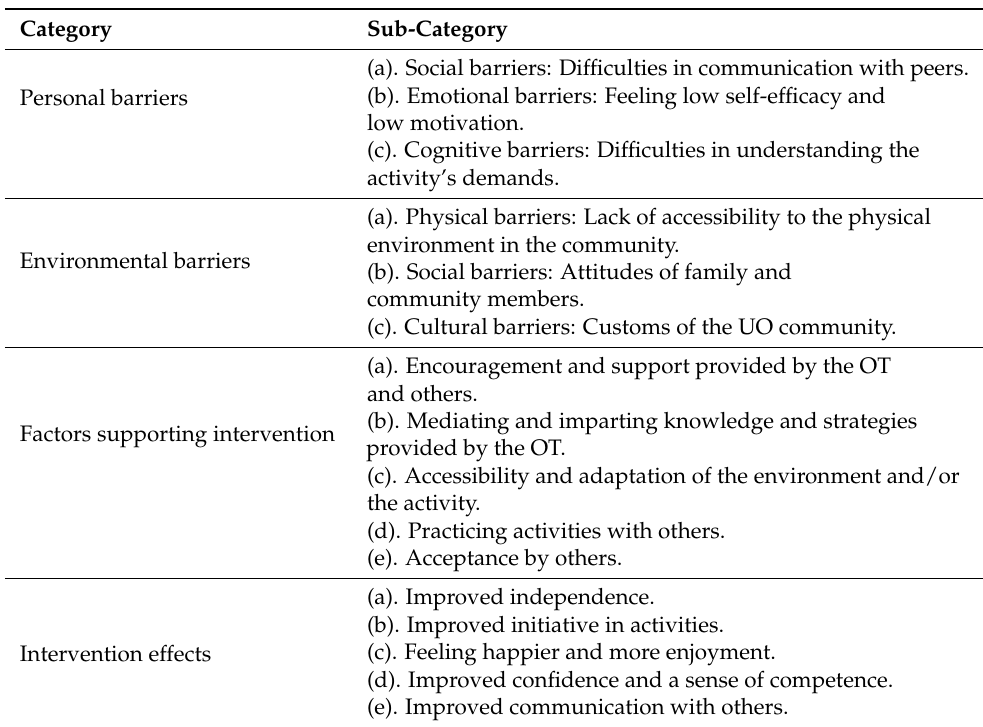
Table 2. Categories and sub-categories that emerged from the interviews.